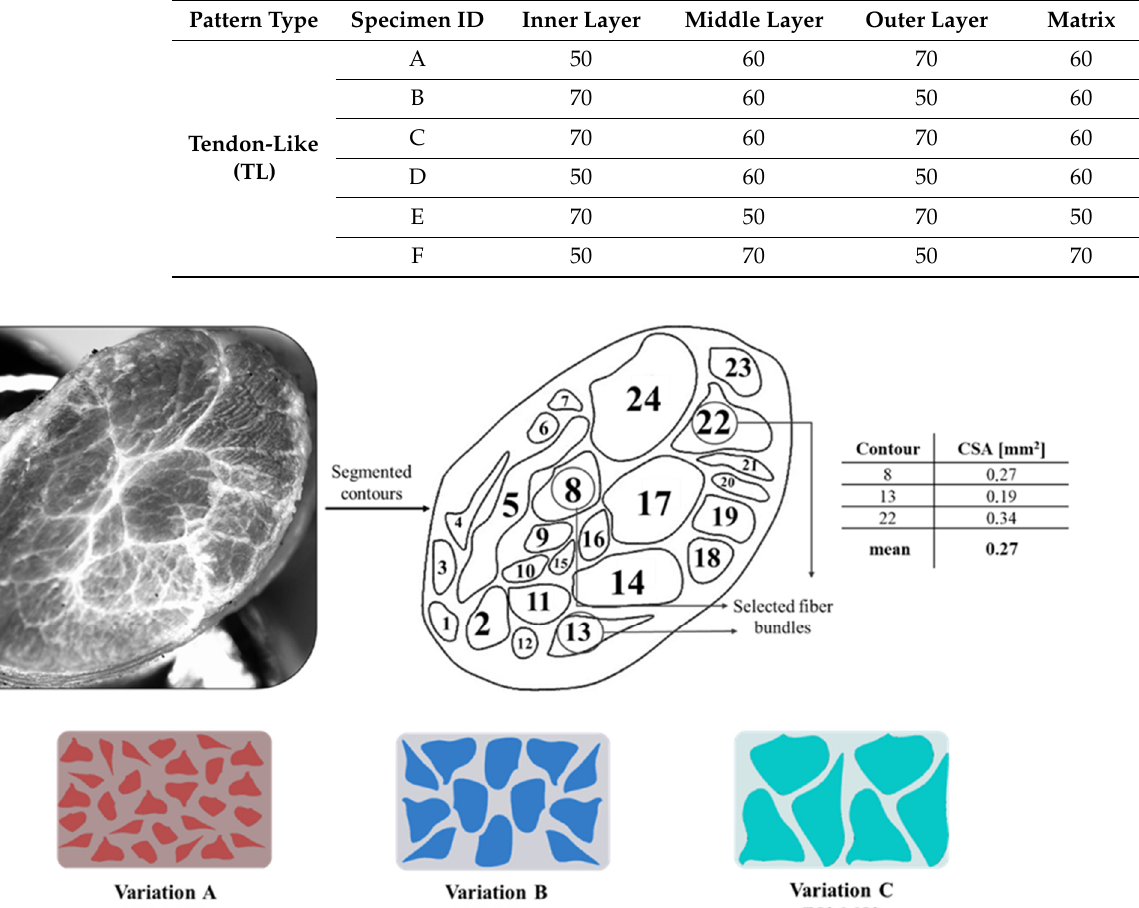
Table 2. Shore A hardness value was assigned for each layer of the Tendon-Mimic (TM) pattern. The range considered was from 50 (medium-soft) to 70 (hard-soft).